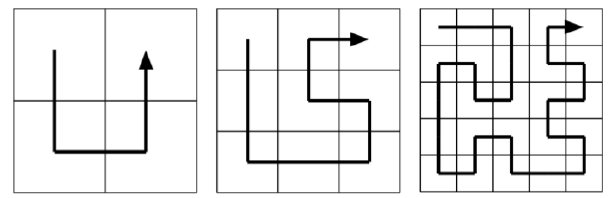
Fig. 2. Examples of the space-filling curve load balancing algorithm, with the Hilbert (left panel), meandering Peano (middle panel) and Cinco (right panel) curves; image from Dennis (2007).